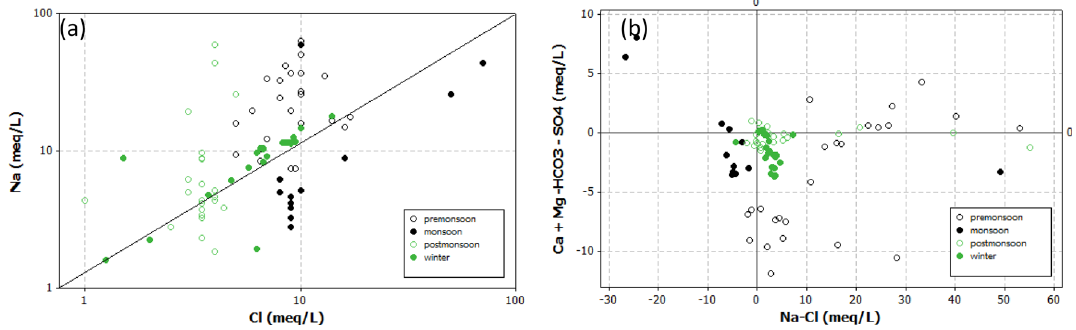
Fig. 6 Bivariate plots of the studied samples showing relationship between a Cl versus Na and b Na–Cl versus Ca + Mg − (HCO